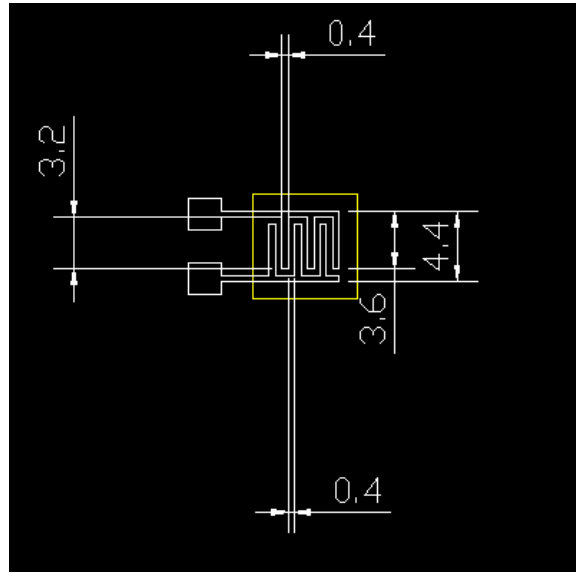
Figure 2. Conductimetric pH sensor using PANI/PVB/PS3 composite material as the pH-sensitive layer (Area outlined by yellow box). All dimensions in the diagram are in